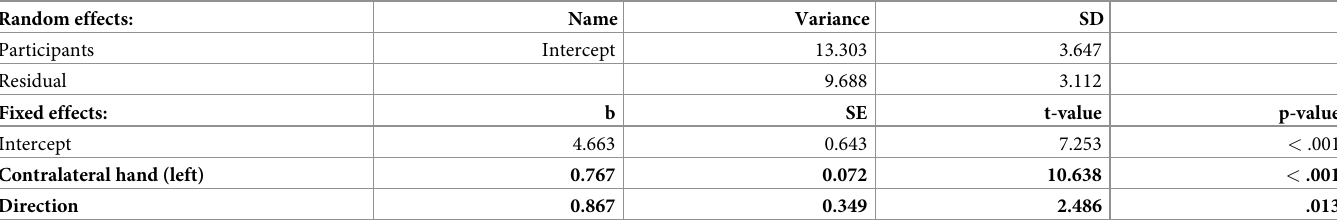
Table 10. Model 2.4. Effect of Direction on the right grip force (after controlling for the contralateral force) in the time window 100–150 ms (Experiment 2). Random effects: